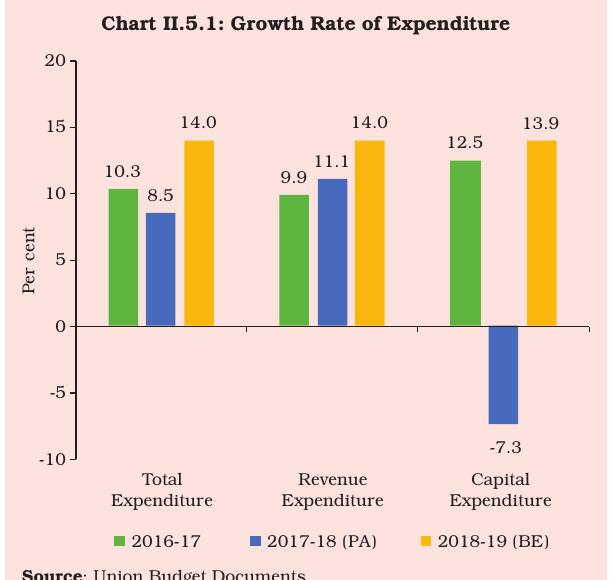
Chart II.5.1: Growth ate of ExpenditureR